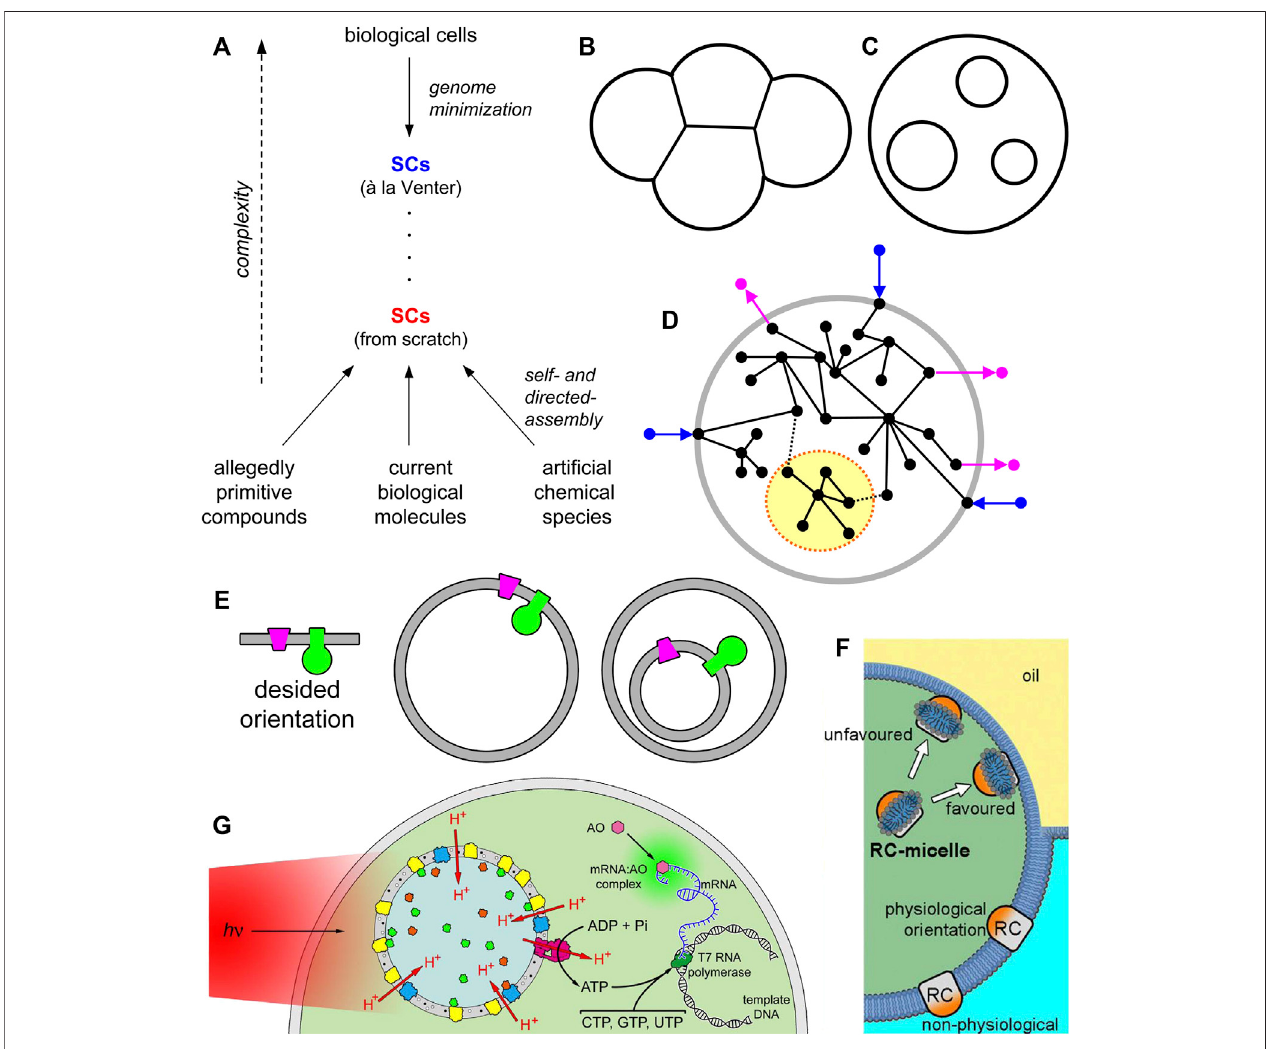
FIGURE 1 | Synthetic cells (SCs) and the nested multicompartment design. (A) Schematic representation of SC research. SCs can be obtained from modern cells by a process of minimization, e.g., by designing, constructing, and insert a minimal genome in living cells. Such an approach has been pioneered by C. Venter (Gibson et al., 2010). The resulting minimal SCs are alive. Bottom-up SCs can be constructed from scratch, by employing different types of molecules (or mixtures of them). The construction grounds on self-assembly and directed-assembly processes. Up to date, bottom-up SCs are not alive and lie at a much lower complexity level when compared with SCs à la Venter. (B) “ Flanked ” or sidewise multicompartment SCs. (C) “ Nested ” multicompartment SCs, also known as multivesicular vesicles or vesosomes in liposome technology. (D) A pictorial representation of the concept of segregation (term borrowed by the dynamic systems theory) which conceptually corresponds to the idea of “ module ” in synthetic biology. In the dynamic chemical network that constitutes the SC (open to the environment)itispossibletoindentify asub-networkwhoserelationallinkswiththewholenetworkareinferior innumber,strength,andquality — becauseofphysical or functional segregation. Note, however, that the “ module ” still interacts with the whole network, i.e., it is not relationally isolated from it. (E) A simpli fi ed cartoon showing that vectorial elements embedded in the membrane (or in general, in any interface) need to have a proper orientation. When such elements should be incorporated in single compartment or multicompartment SCs, their location (and mechanism of insertion) will correspondingly change dramatically. SC technology must allow the decoration of interface with vectorial elements in all possible con fi gurations, at will. (F) Detergent-guided reconstitution of vectorial membrane proteins (MPs) in single compartment SCs from the inside. Image taken from Altamura et al. (2017) with the permission of the National Academy of Science United States ©2017. (G) Chromatophores from Rhodobacter sphaeroides can be employed as organellae-like particles inside giant vesicles, in order to construct SCs capable of producing ATP under illumination. Image taken from Altamura et al. (2021) with the permission of the National Academy of Science United States